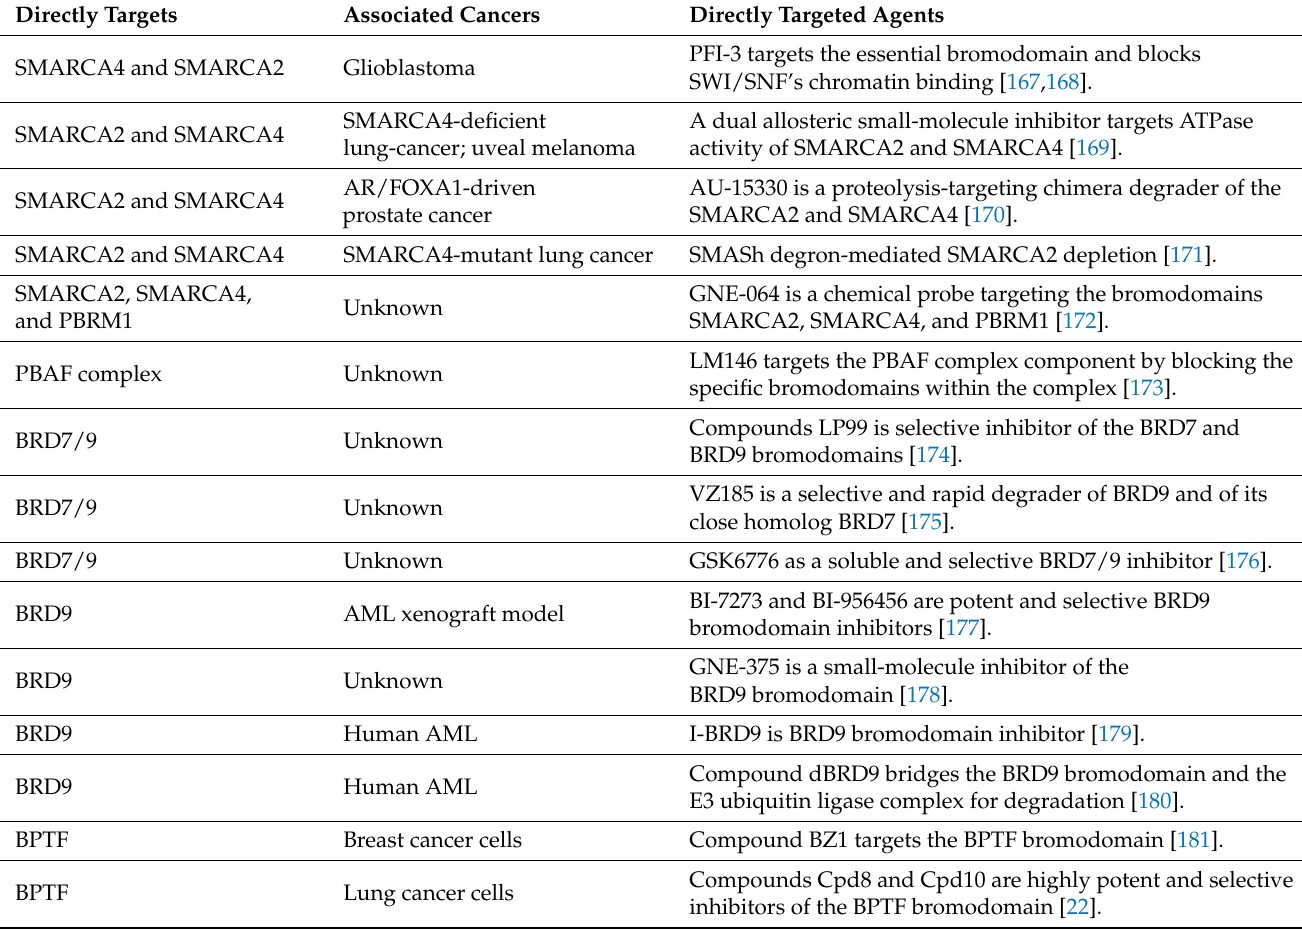
Table 3. Targeted therapies that directly target the aberrant chromatin remodelers as anticancer